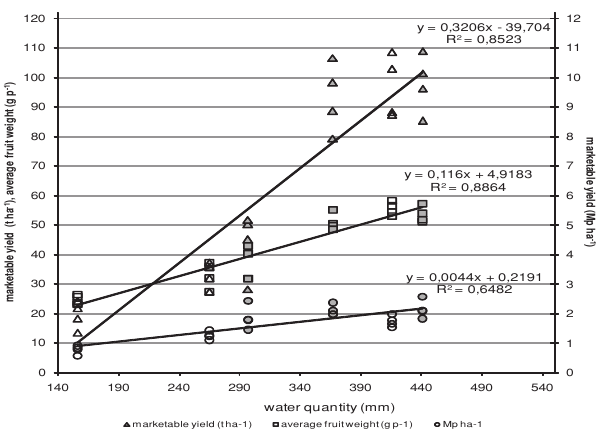
Figure 2: Correlation between water and total marketable yield, pieces and fruit weight of processing tomato in 2008 and 2009 (Brigade F ). The 1 symbols show: ■ : 2008 data, ■■ : 2009 data.